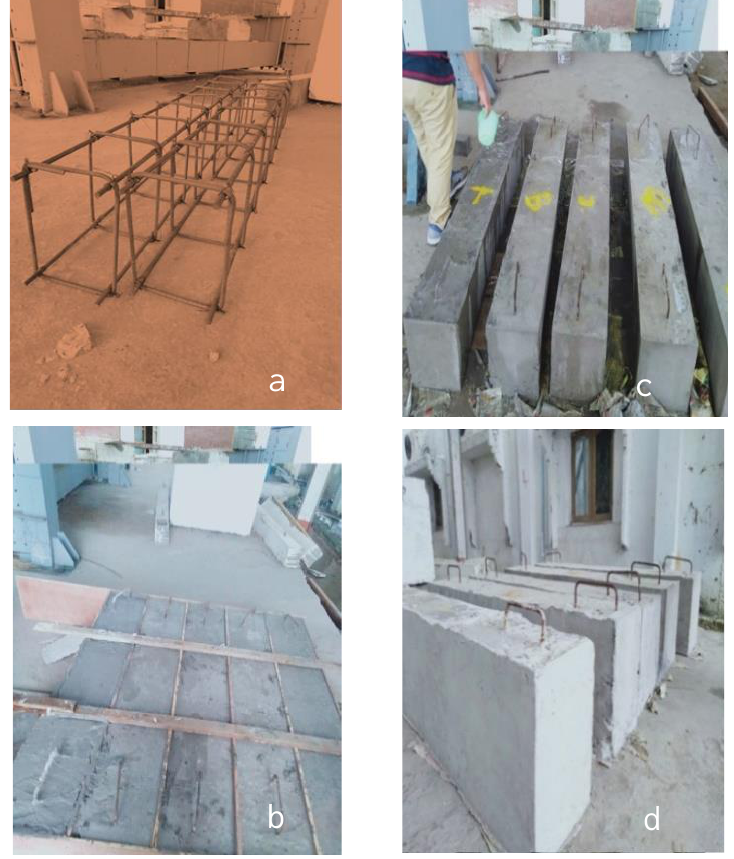
Figure 5. ( a ) Main reinforcement with Stirups; ( b ) Mould filled with concrete. ( c , d ) Drying of beams.